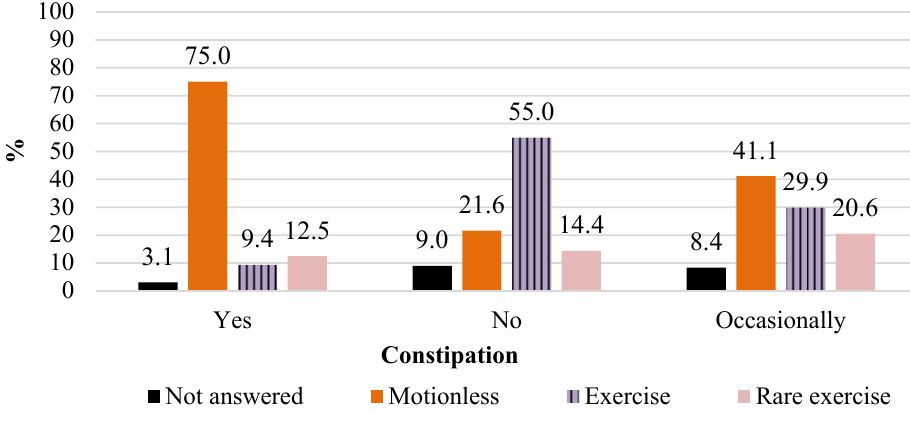
Fig. 7. Physical activity in the study group (p=0.000), n=250 of males declared exercising. Motionless lifestyle was prevalent in the respondents’ group above 65 years old (83.3 % females’ vs 71.4 % males). Nutrition and physical activity was analyzed in relationship to body mass index (Tab. 4). Higher carbo- hydrate (“normal” and “obese” groups) and vegetables (“normal” and “overweight” groups) consumption by females if compared to proteins (all BMI groups) in males was identified. No significant difference by BMI groups in females and males was determined in liquids and coffee and/or tea consumption. Exercises were per- formed in “normal” BMI group (42.5 % of females vs. 56.5 % of